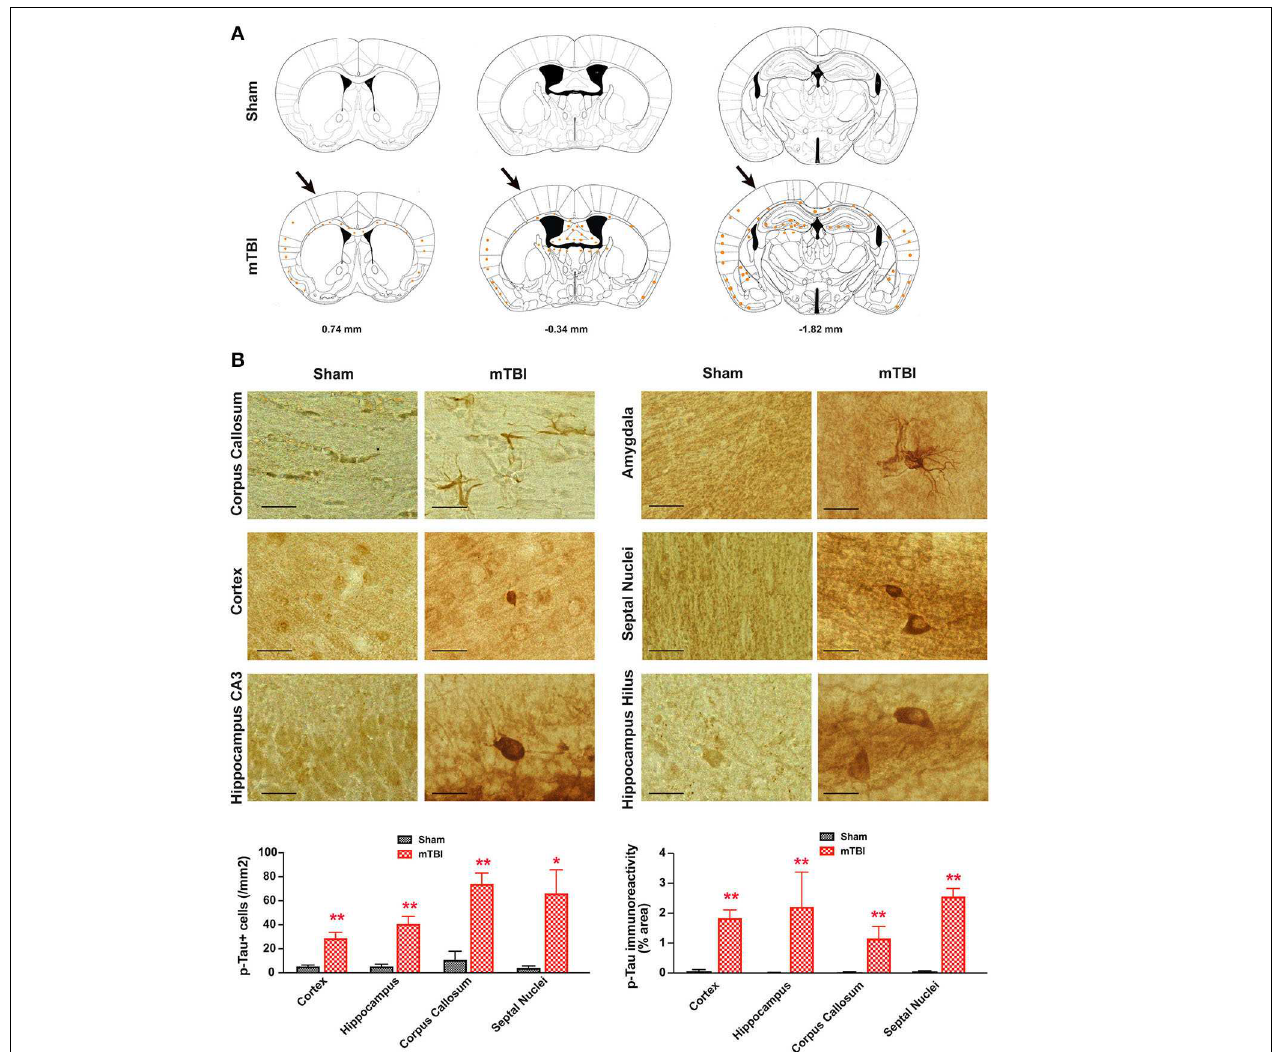
neuropathological alterations were observed in mTBI (bottom) compared with sham (top). Note less p-Tau immunopositive cells in the contralateral side.The arrows in the bottom panel show approximate point of impact. (B) Representative images obtained from ipsilateral side of mTBI showing p-Tau immunoreactive cells in the corpus callosum, amygdala, hippocampus, and septal nuclei. Notice the weak or absence of p-Tau immunoreactivity in sham group. Scale bar = 20 µ